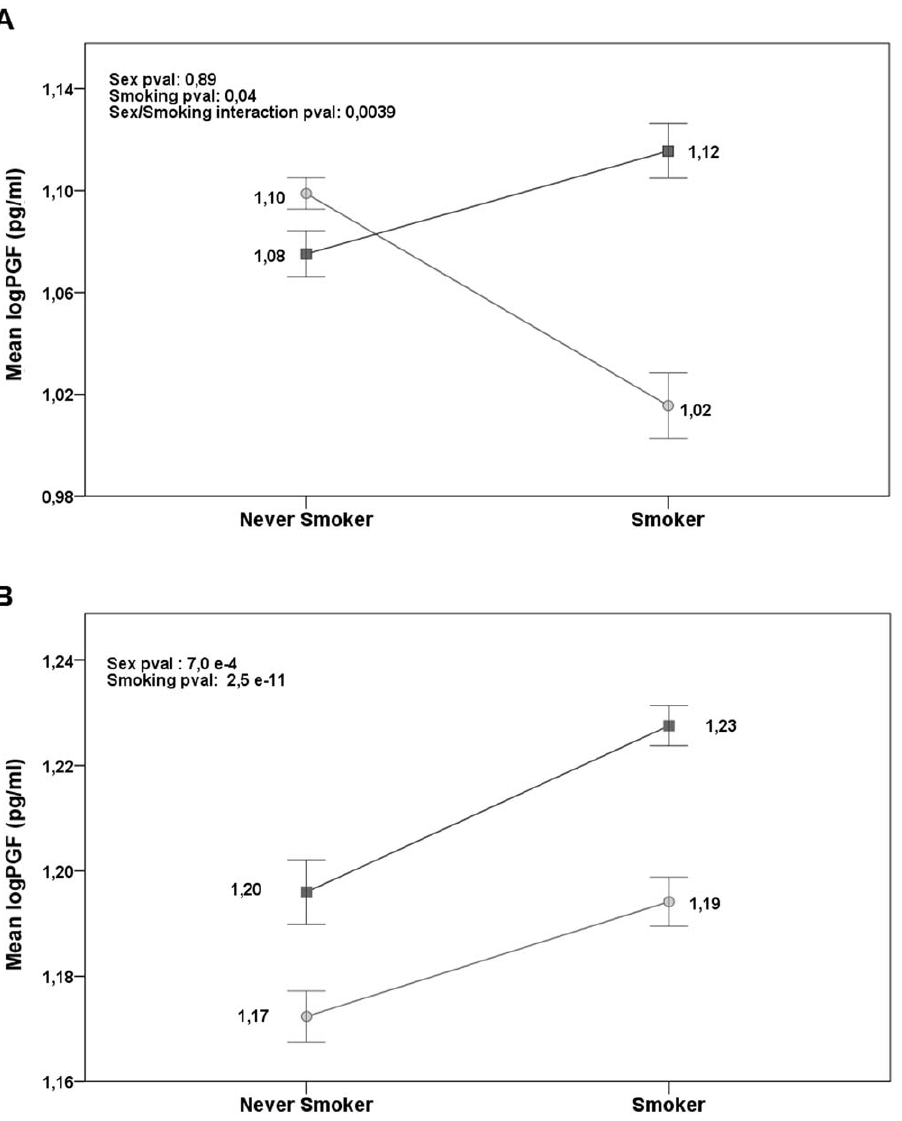
Figure 1. PGF level according to smoking and sex in Cilento and Denmark. Mean levels of the log-transformed PGF and the standard error are reported. A linear regression model includes the log-PGF as a dependent variable, age, sex, menstruation, smoking, sex/smoking interaction, and ‘‘disease status’’ as independent variables for the Cilento sample (A) and age, sex, menstruation, smoking, and ‘‘disease status’’ as regressors for the Denmark sample (B). The p-values for sex, smoking and sex/smoking interaction are shown.